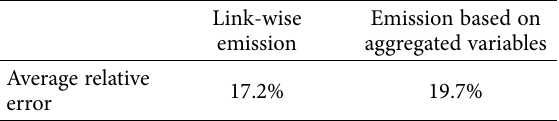
Table 2. Relative error results of Scenario 2 compared to the microscopic model Link-wise Emission based on emission aggregated variables